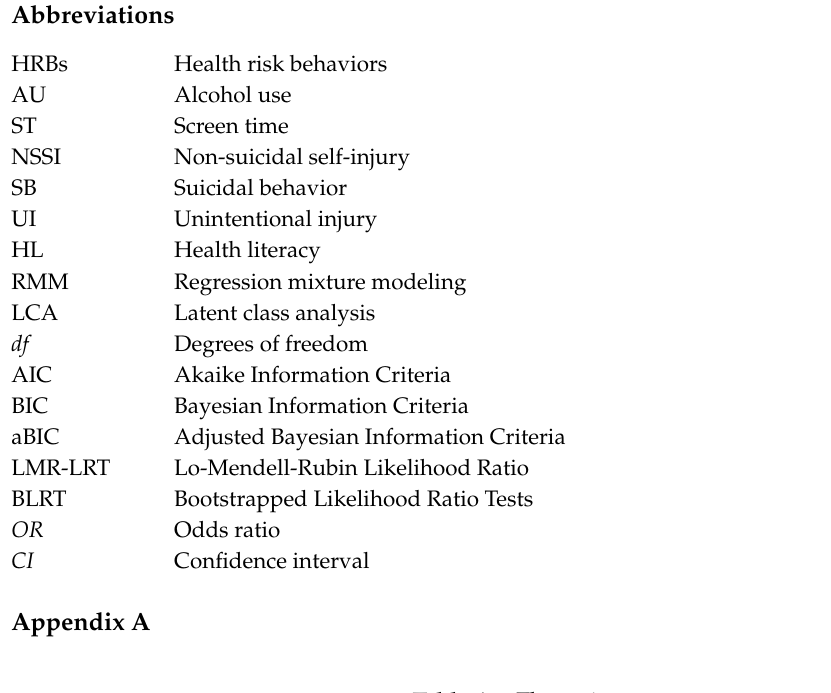
Table A1. The main